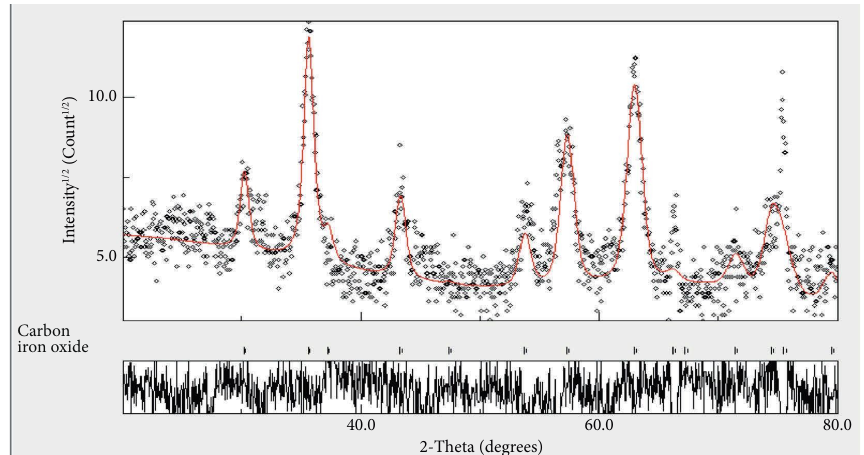
Figure 4: Calculation of quantitative values obtained by X-ray test using Rietveld method for carbon nanotube samples modifed with nanomagnet